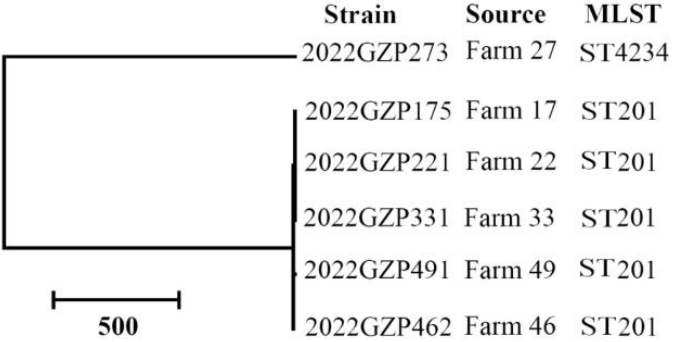
Figure 1. Phylogenetic analysis based on whole-genome multilocus sequence typing (wgMLST) of the six Escherichia fergusonii isolates.